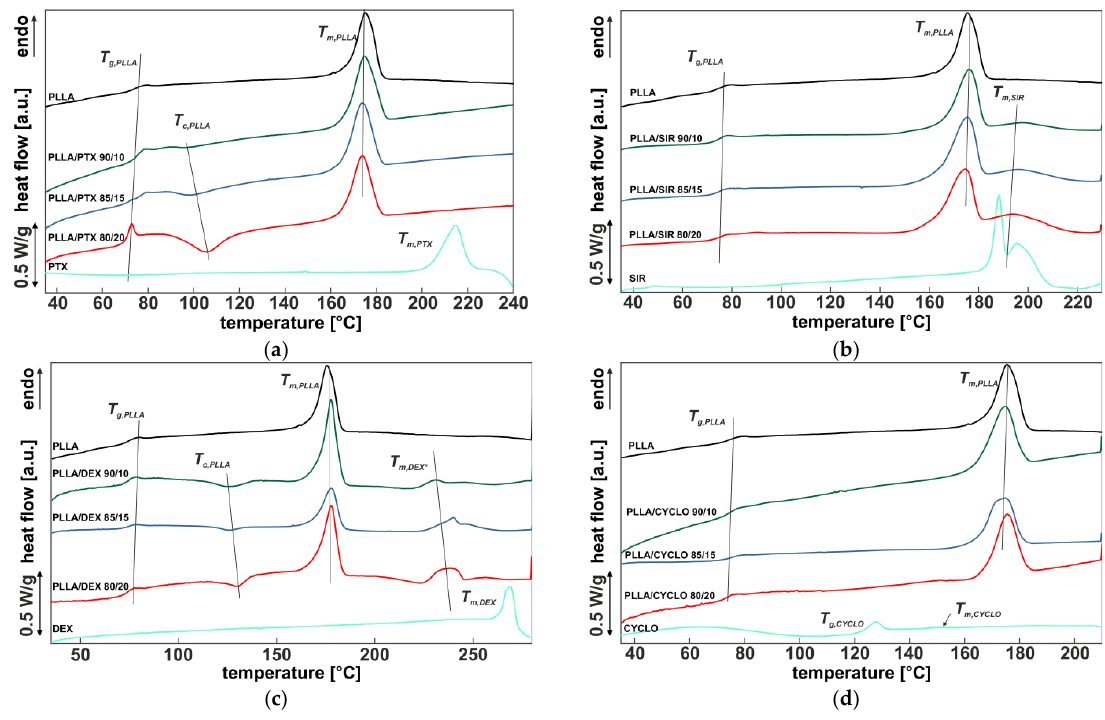
Figure 6. DSC thermograms of PLLA (black), drug (cyan) and PLLA/drug ( a ) PLLA/PTX, ( b ) PLLA/SIR, ( c ) PLLA/DEX and ( d ) PLLA/CYCLO) in different ratios (90/10, 85/15, 80/20 w / w %). The straight lines are guides for the eyes, only.